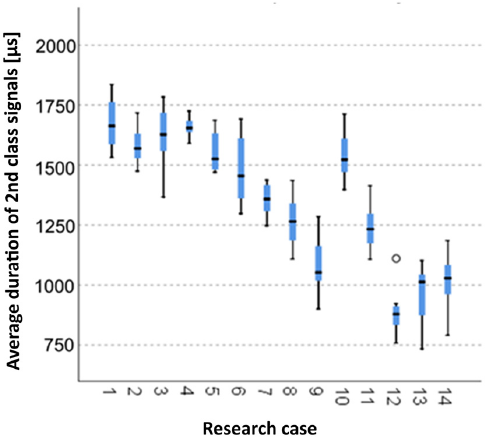
Figure 21. The graphical representation of the Kruskal–Wallis test results for independent tests of the average duration of the class 2 signals.